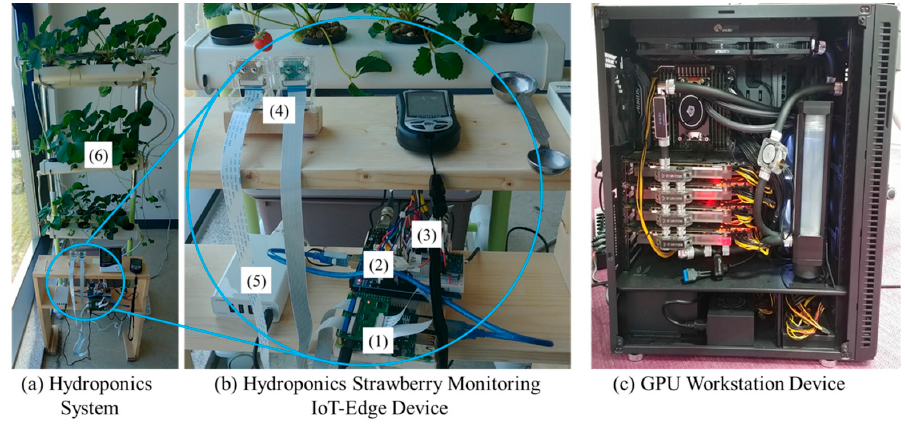
Figure 1. The hydroponic s trawberry monitoring and harvest decision